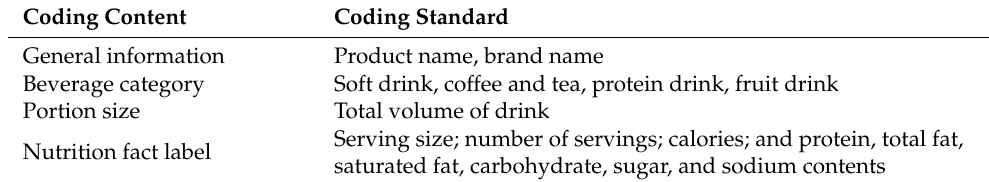
Table 1. Coded components of food packaging information.